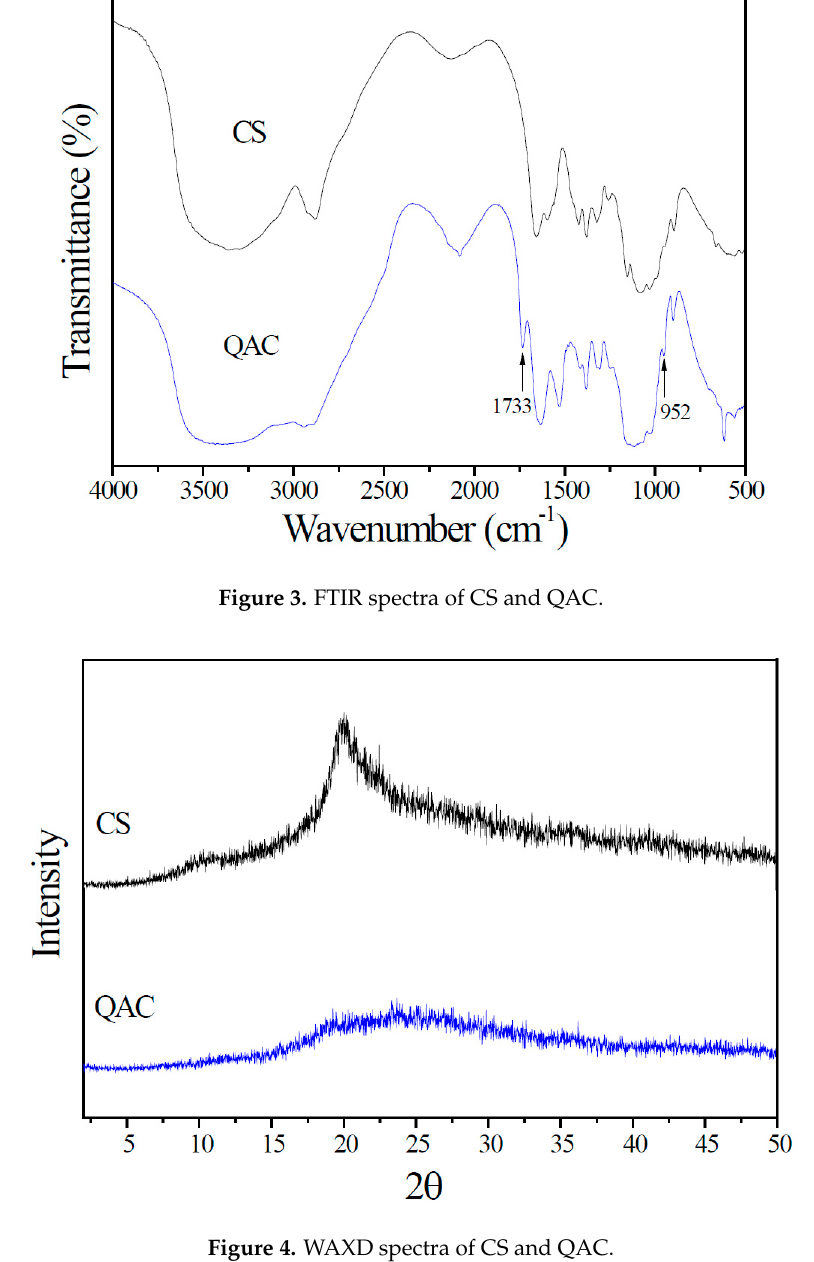
Figure 4. WAXD spectra of CS and QAC.